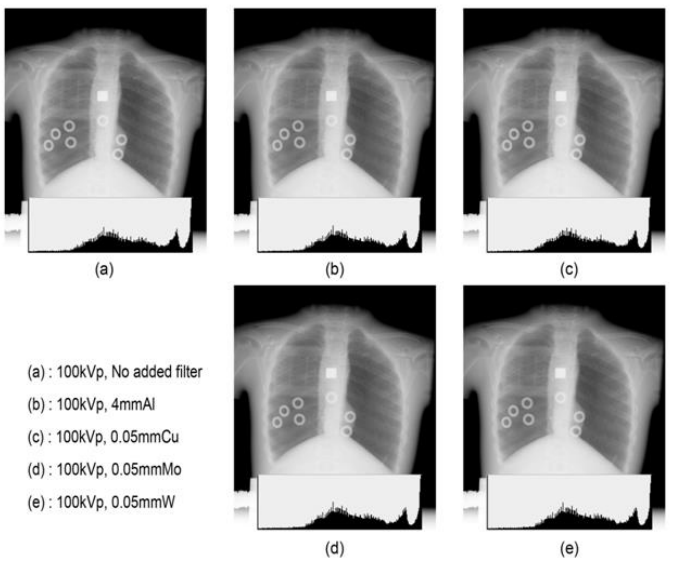
Figure 5. Image quality and histogram of various filters (Al, Cu, Mo, W, and no filter) .